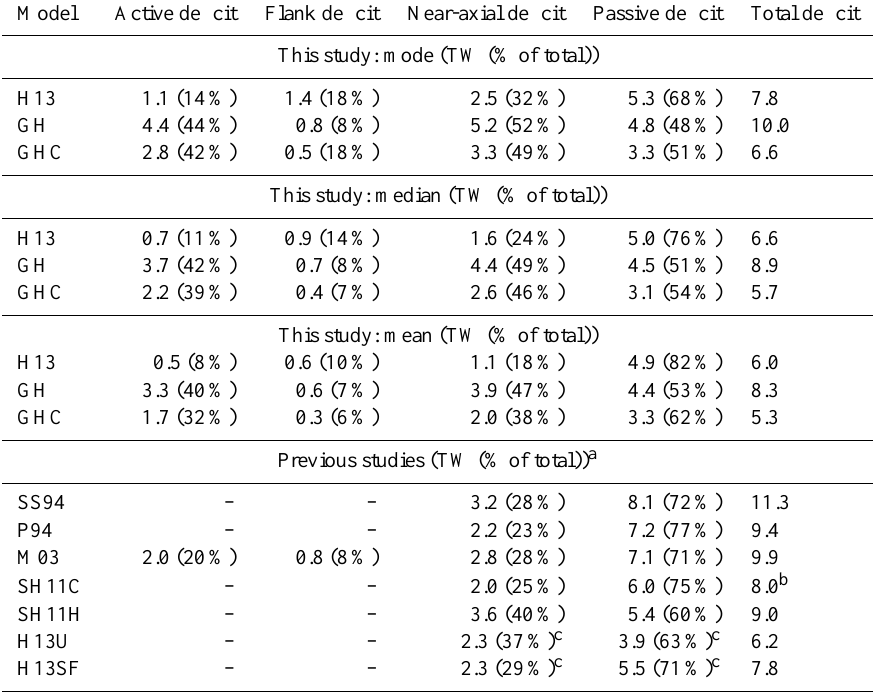
Table 1. Comparison of heat flow deficit estimates for different seafloor domains for this study compared to previous studies. Model Active deficit Flank deficit Near-axial deficit Passive